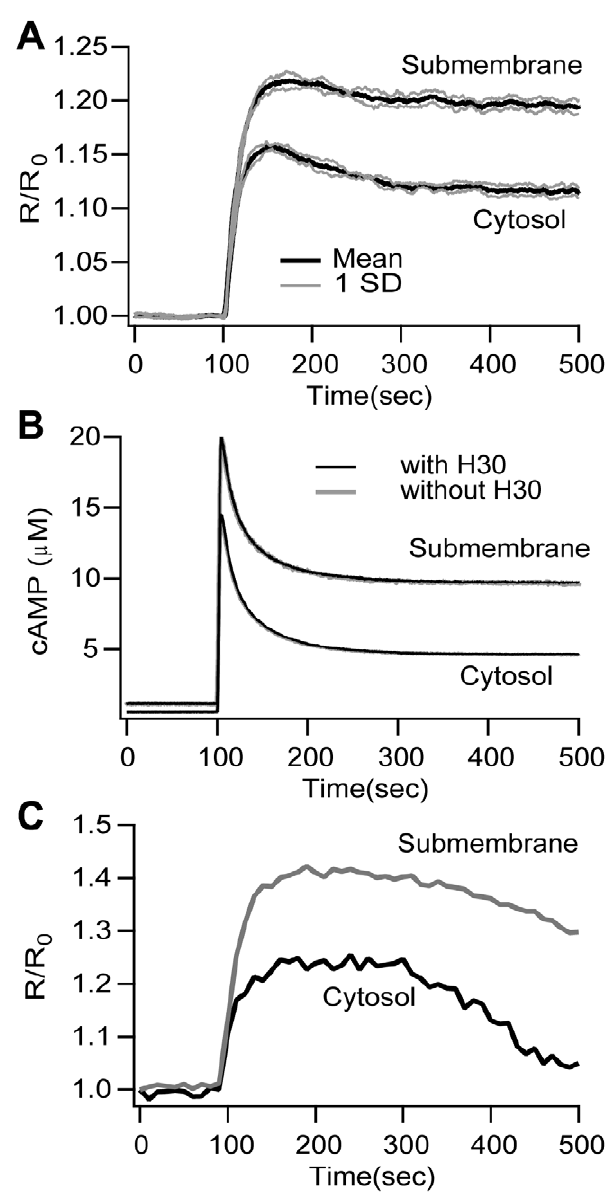
Figure 4. The theoretical FRET signal and cAMP concentration show microdomains without diffusional barriers. (A) The FRET signal for the submembrane region is 6.8% higher than the cytosol. Mean (black traces) and 6 SD (gray traces, n=5). (B) Difference between submembrane and cytosolic cAMP concentration is similar to that observed for the FRET signal, and is independent of overexpression of the H30 sensor. The model cell with H30 is shown in black; the model cell without H30 is shown in gray. SD traces are not illustrated because they overlap with the mean. No diffusional barriers are present for these simulations. The expression of the sensor does not disturb the cAMP microdomain, therefore the difference between submembrane FRET and cytosolic FRET is not an artifact of the method. (C) Representative kinetics of FRET changes recorded in cells expressing either the membrane targeted sensor mpH30 or the cytosolic sensor H30 [16,56] upon stimulation with 1 m M PGE 1 . FRET experiments were performed as described previously in